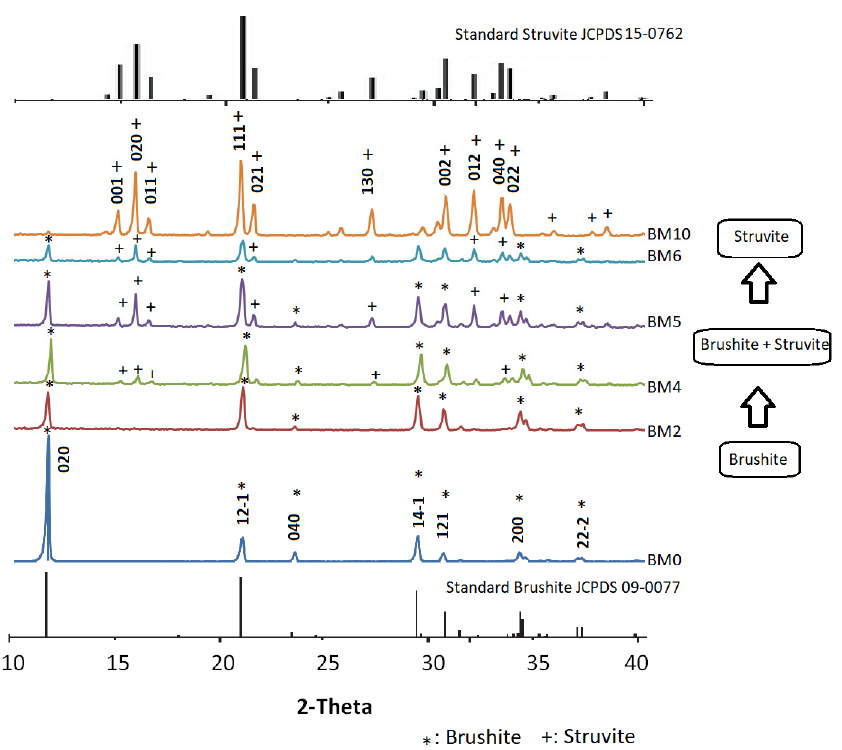
Figure 2. XRD patterns of the Ca 1 − x Mg x · HPO 4 · nH 2 O compounds (synthesis details are shown in Table 1).